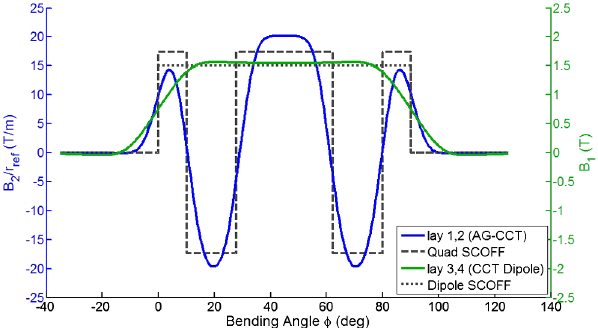
FIG. 11. The dipole (B 1 ) and alternating quadrupole (B 2 =r contributions from the CCT dipole and AG-CCT layers are shown as a function of bending angle for the 90 degree bend (B3). Note that r is the bore radius which is listed in Table ref